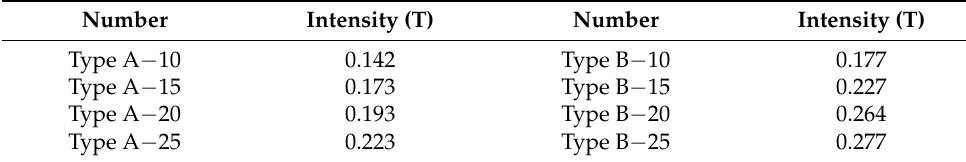
Table 4. Magnetic field intensities applied to test samples.